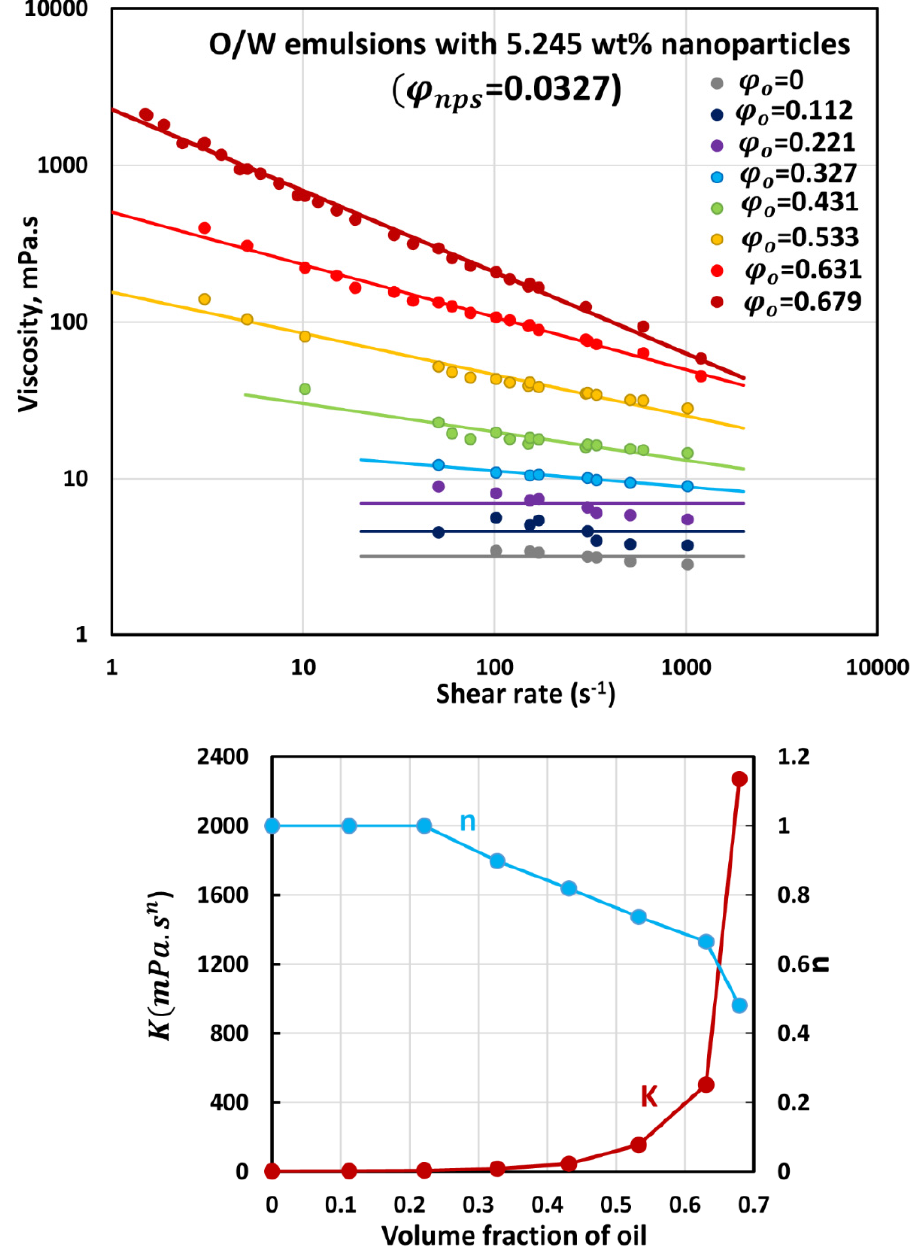
Figure 6. Flow behavior of O/W emulsions thickened with starch nanoparticles at nanoparticle concentration of 5.245 wt% ( ϕ nps = 0.0327).